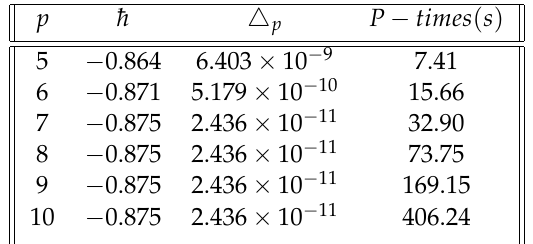
Table 2. Convergence and uniqueness of the series expansion by selecting an appropriate auxiliary parameter, when the amount of P-time is rounded up to two